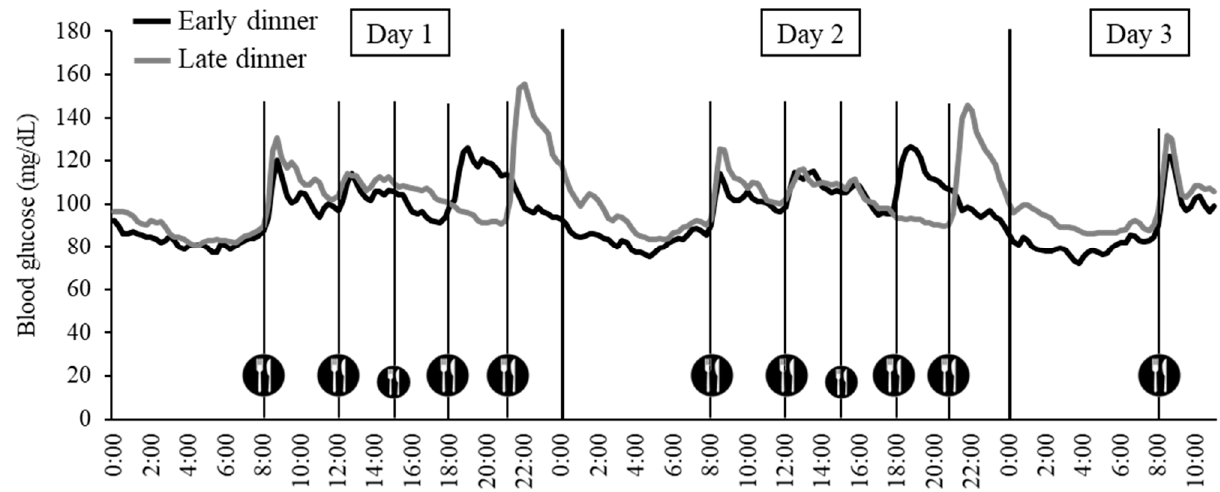
Figure 2. Blood glucose fluctuations from Day 1 to Day 3.